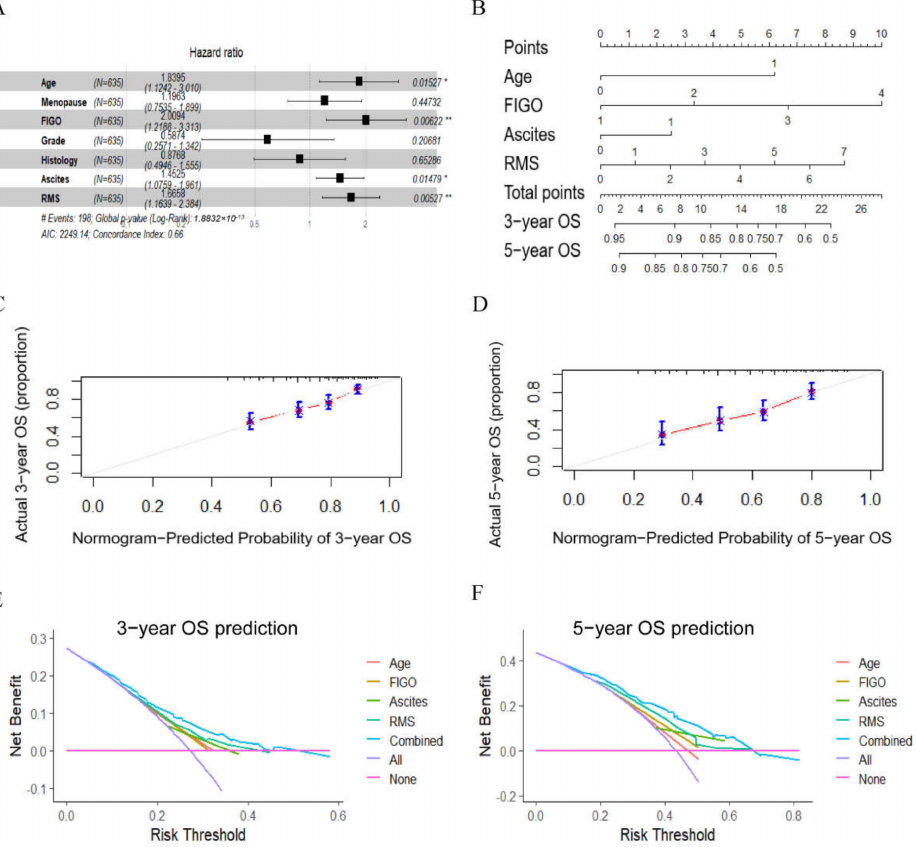
Figure 3. OS prediction based on RMS, age, FIGO stage and ascites volume. ( A ) Multivariate Cox analysis revealed age, FIGO, ascites and RMS to be independent risk factors for OS prediction. * p < 0.05, ** p < 0.01. ( B ) Nomogram to predict OS survival probability at 3 and 5 years. ( C ) Calibration curve for the nomogram predicting 3-year OS. ( D ) Calibration curve for the nomogram predicting 5-year OS. ( E ) DCA for the nomogram predicting 3-year OS. ( F ) DCA for the nomogram predicting 5-year OS. DCA, decision curve